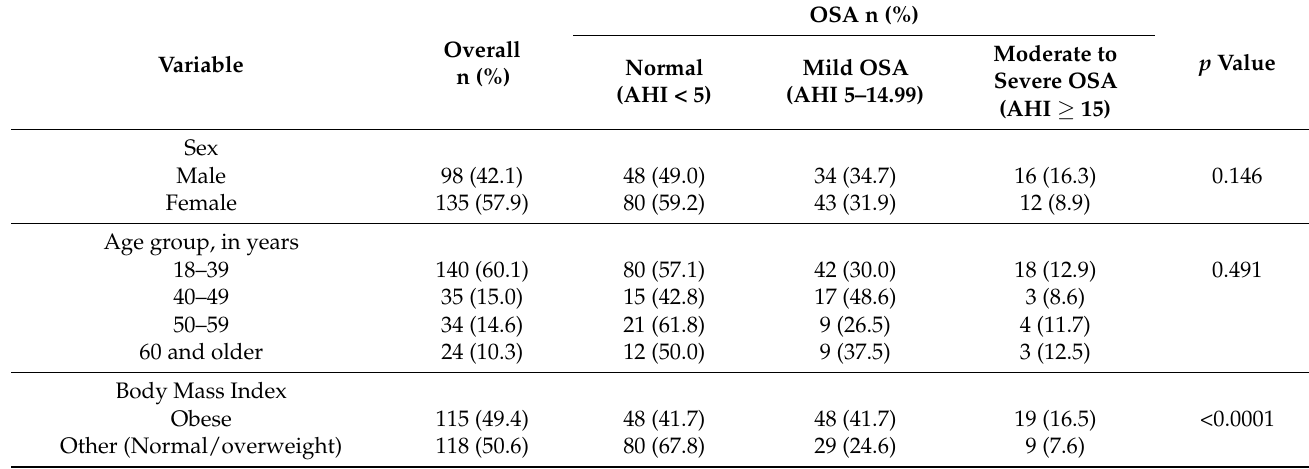
Table 1. Association between OSA and selected risk factors (n = 233).